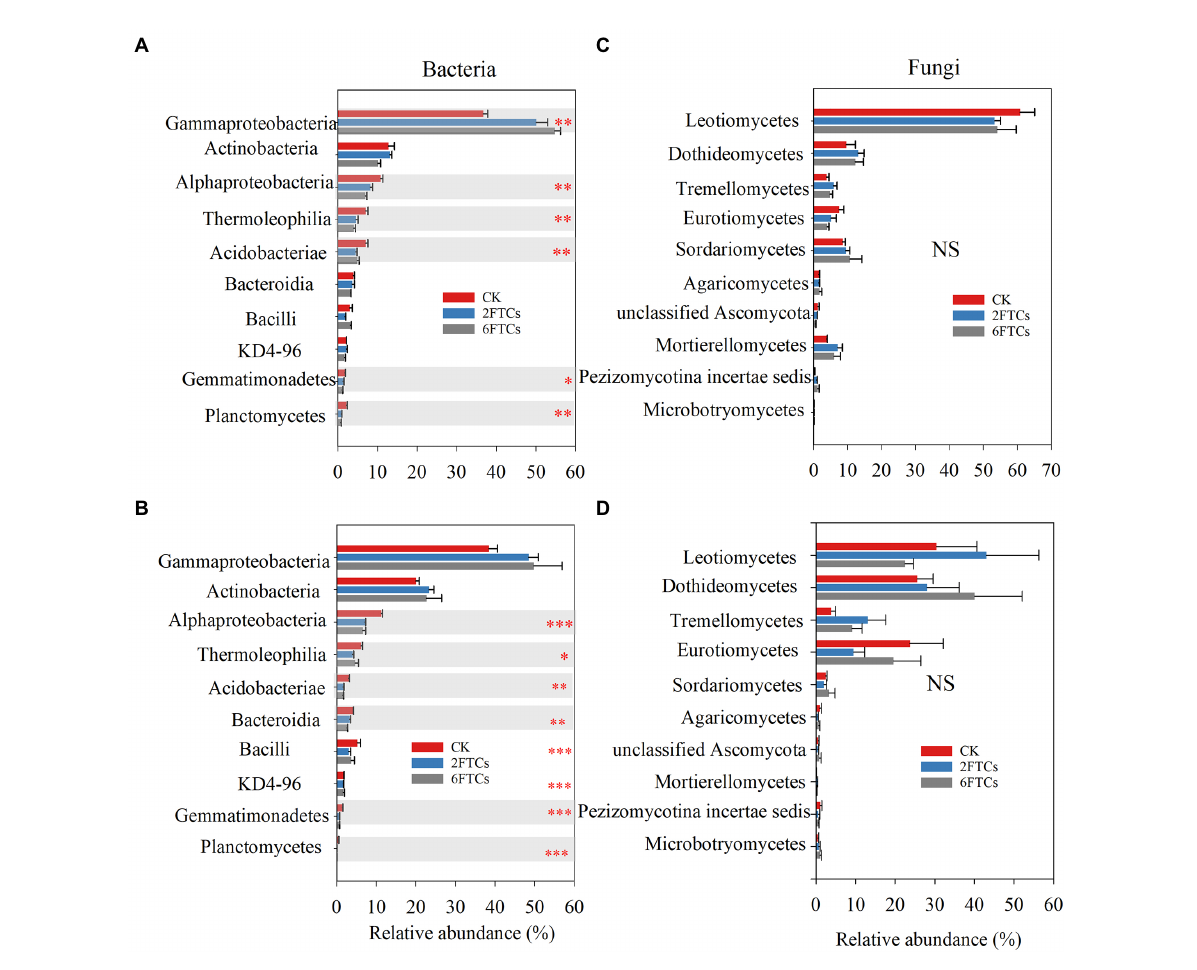
FIGURE 5 The relative abundance of dominant bacterial class in (A) 0–10 cm; (B) 50–60 cm, and fungal class in (C) 0–10 cm; (D) 50–60 cm in response to different freeze–thaw cycles. CK, 2FTCs, and 6FTCs represent culture at 5 ° C, two freeze–thaw cycles, and six freeze–thaw cycles, respectively. *, **, *** indicate significant differences at p < 0.05, < 0.01, and < 0.001, respectively. NS means no significant difference between the two soil